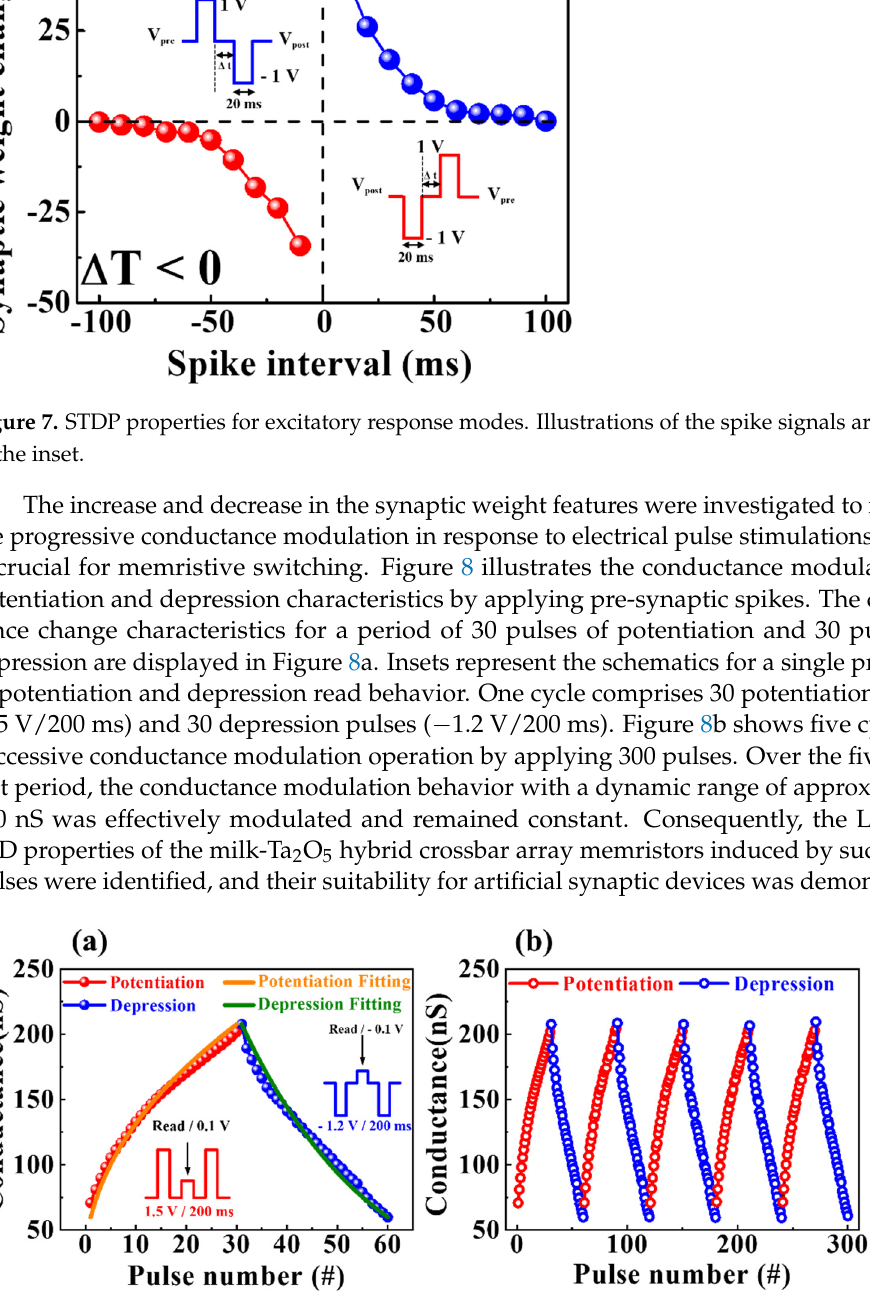
Figure 8. ( a ) Conductance change characteristics for 1 cycle of 30 pulses of potentiation and 30 pulses of depression. ( b ) Five cycles of successive conductance modulation operation by applying 300 pulses.